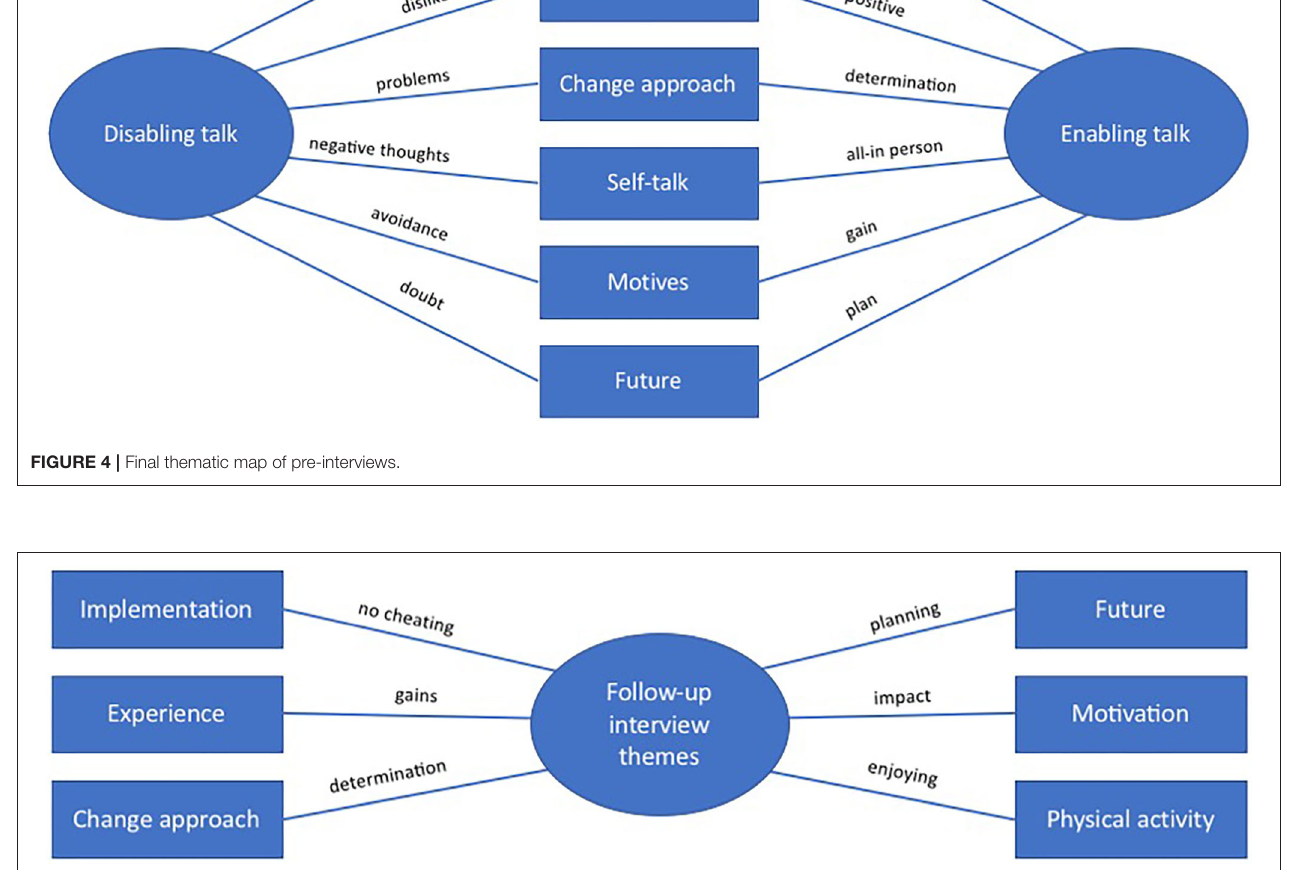
FIGURE 5 | Final thematic map of follow-up interviews.